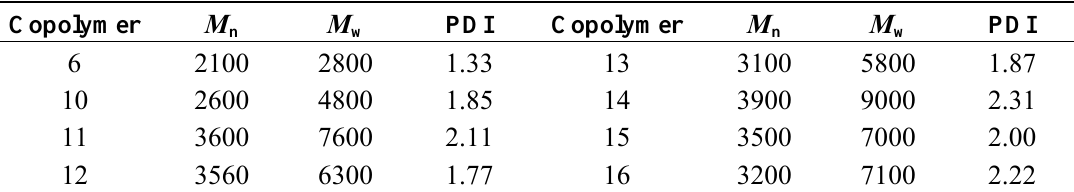
Table 2. Number average ( M ) and weight average ( M ) molecular weights and n w polydispersity indices (PDIs) of copolymers 6 and 10 – 16 measured by size-exclusion chromatography in tetrahydrofuran the calibration